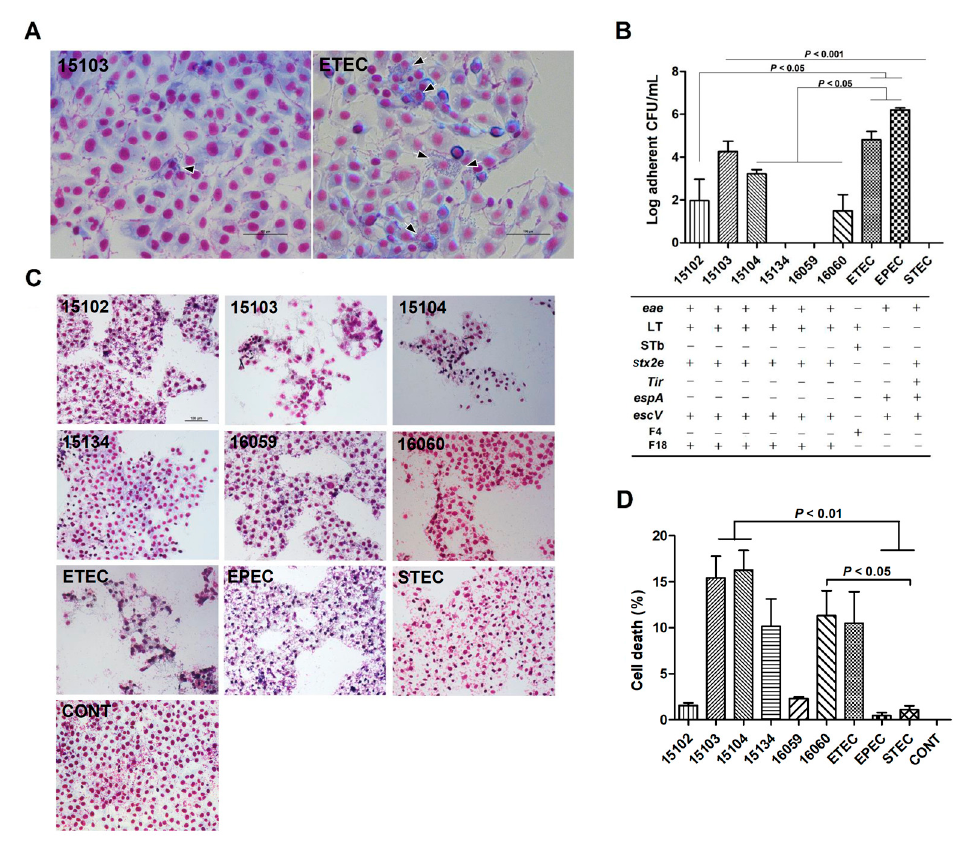
Figure 5. Adherence and cytotoxicity of E. coli hybrid strains to intestinal epithelial cells. The representative adherent phenotype ( A ) and adherence rate ( B ) of 6 E. coli hybrid isolates on porcine intestinal epithelial J2 cells (IPEC-J2) cells at 3 h after challenge are presented. Enterotoxigenic E. coli (CVCC 225), enteropathogenic E. coli (CVCC1450) and Shiga toxin-producing E. coli (CICC 10670) were used as positive controls, and PBS (CONT) was used as a negative control. The release of LDH was measured in supernatant collected from the indicated IPEC-J2 cell cultures at 3 h after E. coli challenge. The monolayers were washed, fixed, and stained with Giemsa. Scale bars, 100 µm. Data are presented as the mean ± SEM of 3 independent experiments.